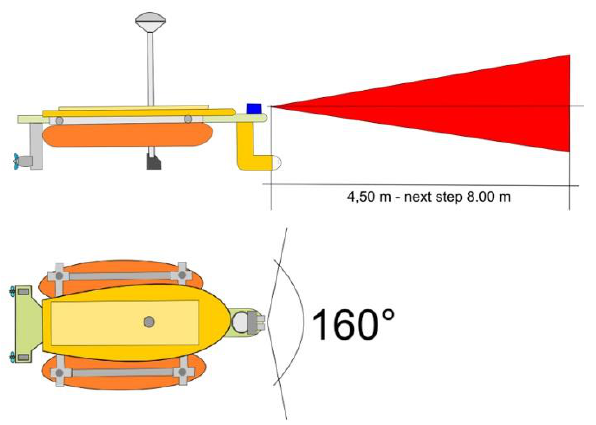
Figure 7. Action range of anti-collition system.